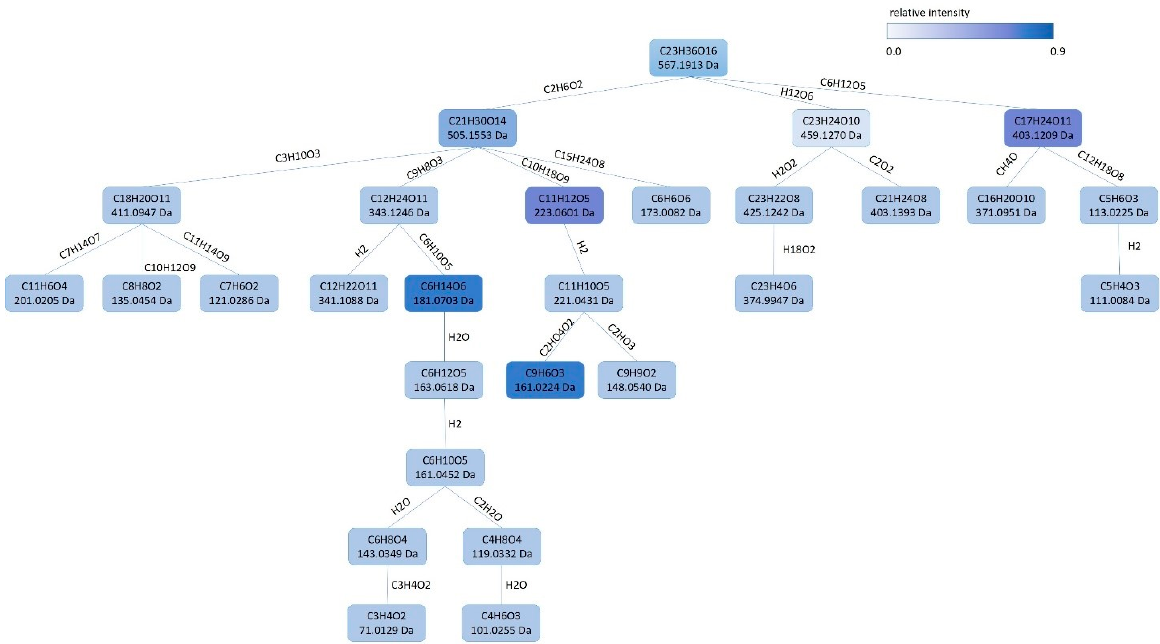
Figure 2. Fragmentation pattern tree from Sirius [43] of eribioside ( 17 ) found in O20 olive byproduct extract with shared MS ion spectrum with allobetonicoside ( 16 ) and another related compound ( 15 ).